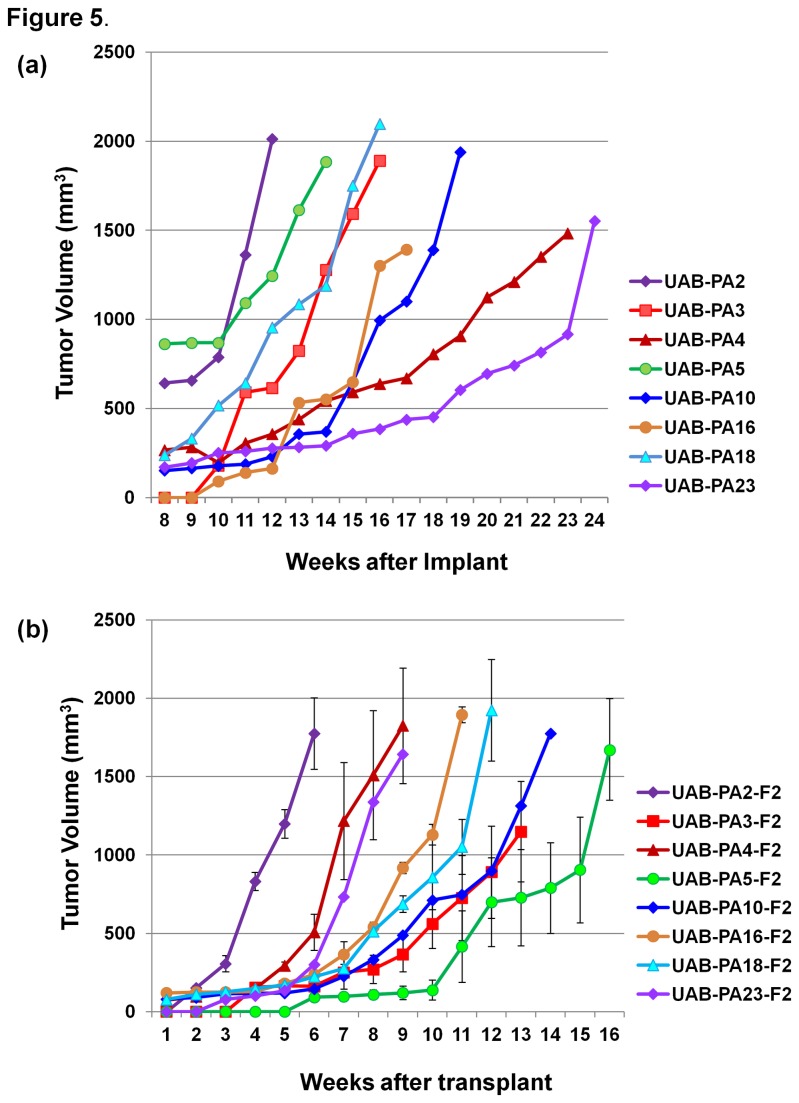
Tumorgraft growth curves.(a) First generation (F1) tumorgraft growth curves. (b) Second generation (F2) tumorgraft growth curves. Tumors were measured using vernier calipers once a week until tumor volumes reached ~1,500 mm3. Details of the procedure and calculations to determine tumor volume are as described in Methods. The graph in the figure was generated using Microsoft excel software.